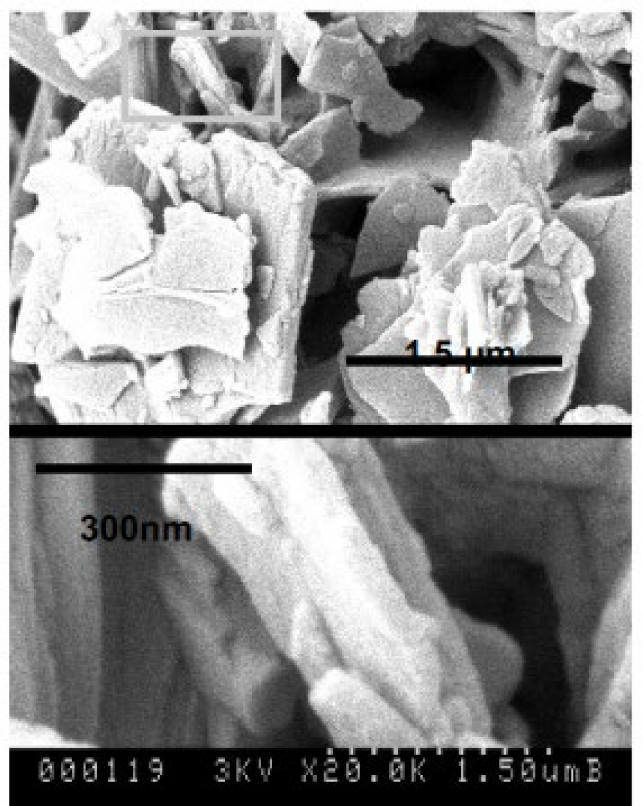
Figure 10. SEM micrograph of PACN powder.